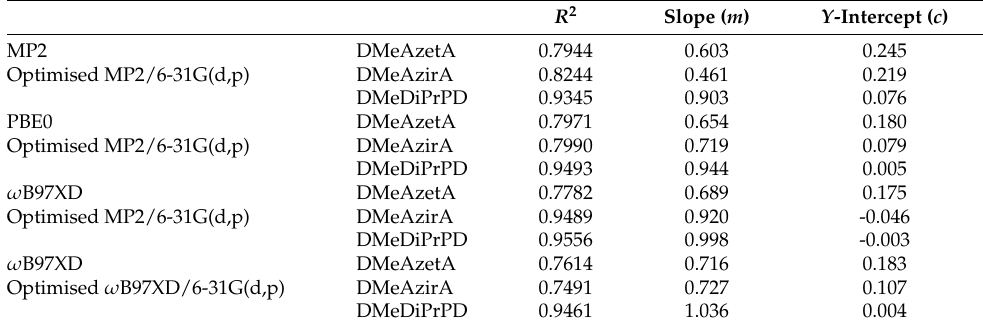
Table 8. Linear regression analysis of MP2, PBE0, and ω B97XD for both problematic